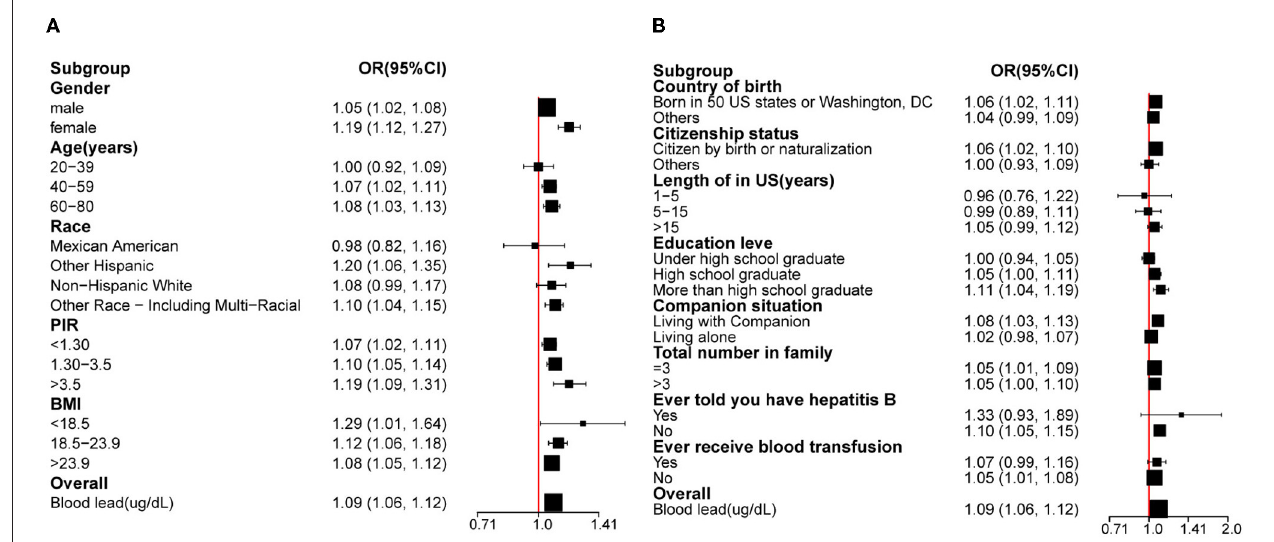
FIGURE 4 | The association between blood lead levels and HBcAb. (A) Subgroup analysis was performed according to gender, race, age, and BMI. (B) Subgroup analysis was performed according to the country of birth, citizenship status, length of stay in the United States, education level, companion situation, total number of people in the family, ever informed about hepatitis B status, and ever received blood transfusion. *All the covariates are in the fully adjusted model. In the subgroup analysis stratified by each covariate, the model is not adjusted for the stratification variable